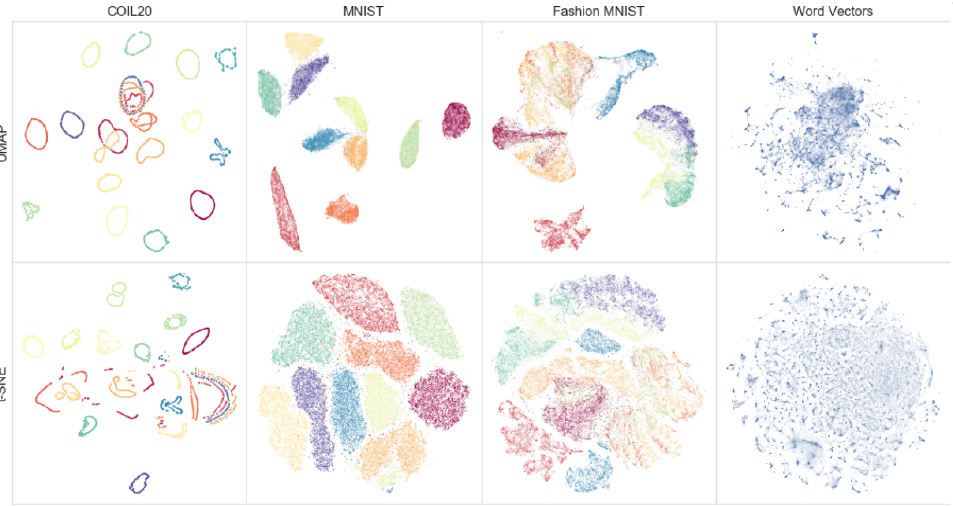
Figure 3. Comparing UMAP and t-SNE applied to some well-known datasets. Point colors represent data labels in each dataset. Source: McInnes et al.